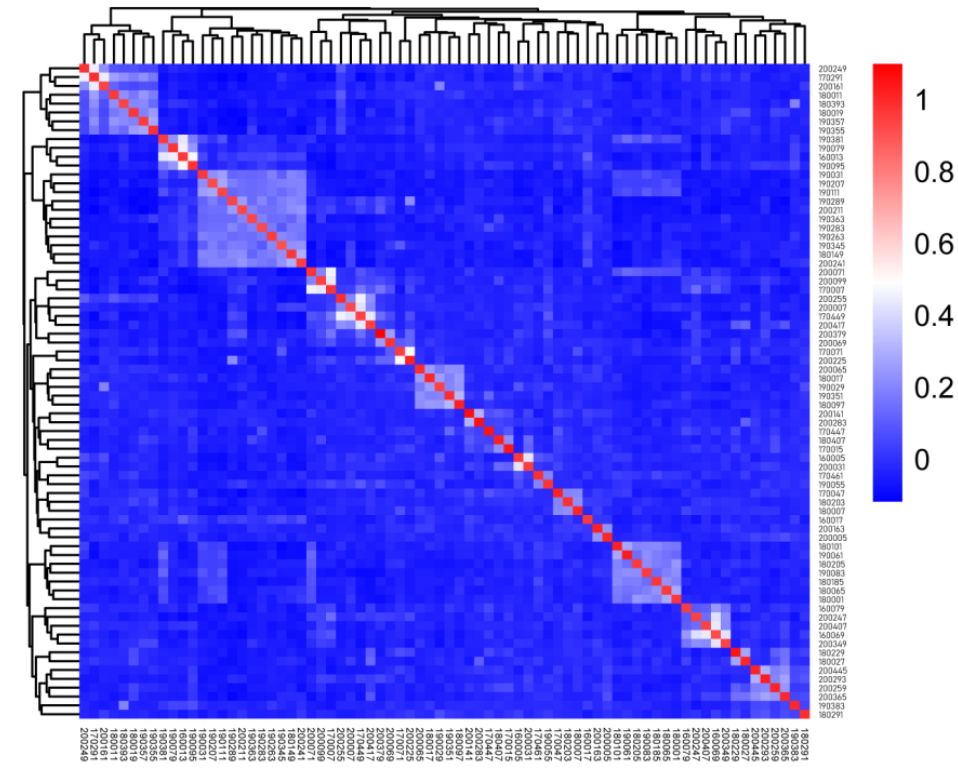
Figure 3. G matrix visualization of this population in Tan sheep.